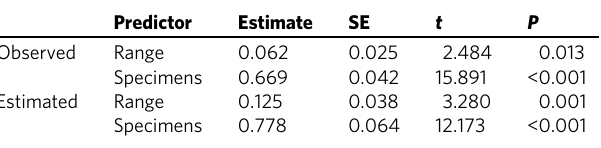
Table 1 Results of phylogenetic generalised least squares models relating observed and estimated number of haplotypes with species range and number of sequenced